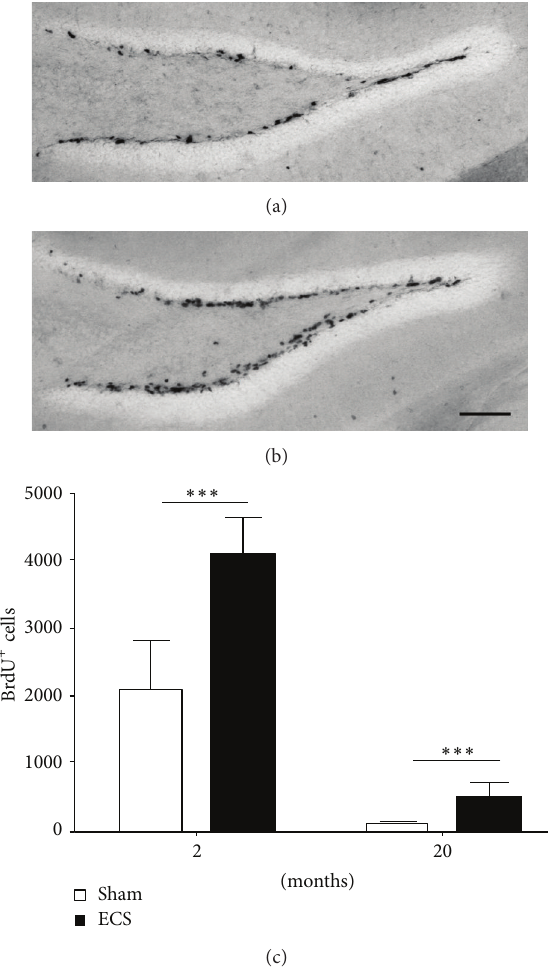
Figure 2: Representative micrographs showing the detection of BrdU-labelled cells in the dentate gyrus of a 2-month-old mouse from (a) the sham group or (b) the experimental ECS group. Scale bar: 200 𝜇 m. (c) The number of BrdU + cells was determined to estimate the rates of cell proliferation in the dorsal DG of 2- and 20- month-old mice. Both groups showed a highly significant enhance- ment in cell proliferation following experimental ECS-treatment. Two months, 𝑃 < 0.0001 ( ∗∗∗ ); 20 months, 𝑃 = 0.0004 ( ∗∗∗